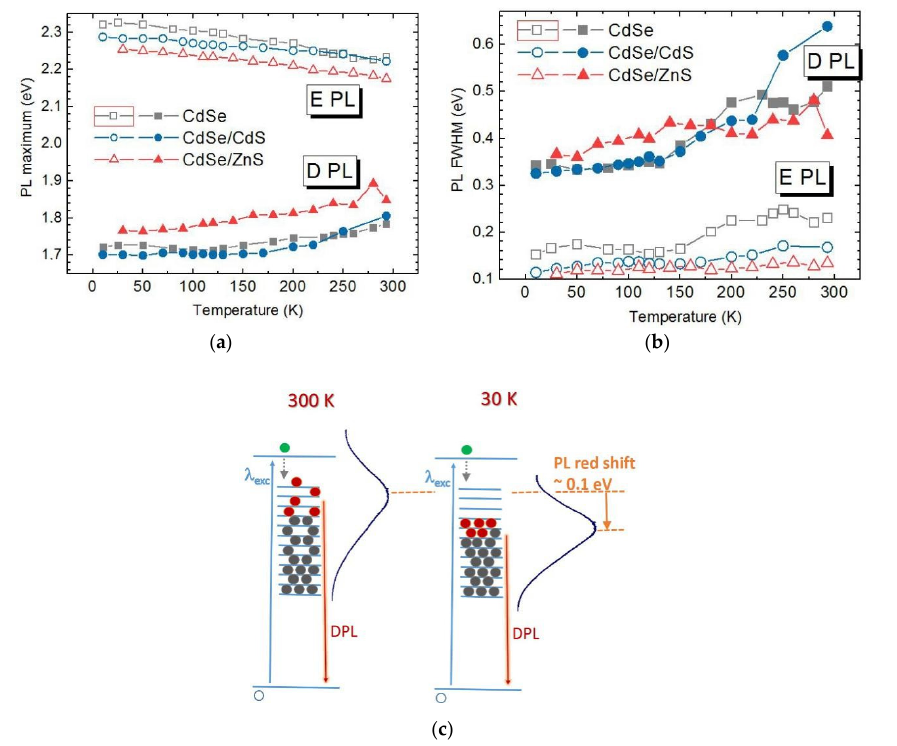
Figure 9. Temperature dependence of the peak position ( a ) and FWHM ( b ) of EPL and DPL bands of CdSe, CdSe, and CdSe/ZnS NCs stabilized with gelatin ( λ exc = 441.7 nm, 0.1 W/cm 2 ). The schematic in ( c ) illustrates the assumed mechanism behind the observed red shift of the trap-related PL with temperature decrease.